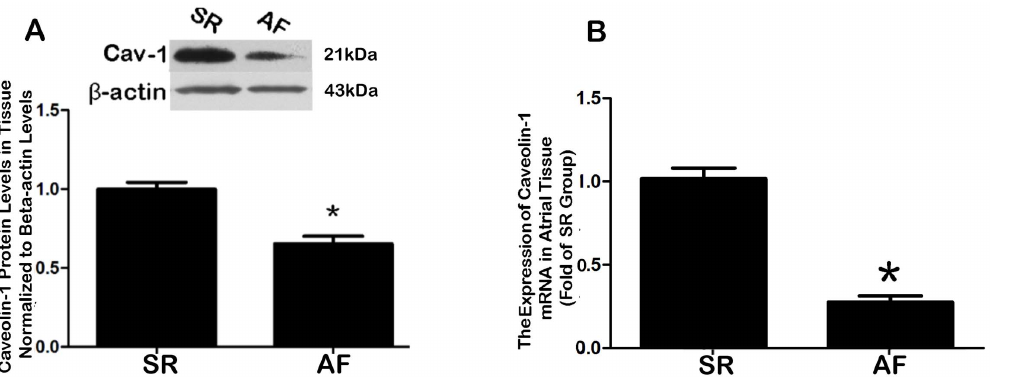
Figure 1. Quantitative analyses of caveolin-1 (Cav-1) expression in human atrial tissues. A , Comparison of atrial Cav-1 protein levels between AF and SR subjects, as determined by Western blot analysis. The left panel shows the representative bands, and the right panel the shows the mean data of band density normalized to b -actin. *P , 0.001 vs. SR, n=10; B , Comparison of atrial Cav-1 mRNA levels between AF and SR subjects, as determined by real-time RT-PCR (qRT-PCR). *P , 0.001 vs. SR; n=10. Note that the expression of Cav-1 was decreased at both protein and transcript levels in patients with AF compared to patients with SR. Cav-1, caveolin-1; SR, sinus rhythm; AF, atrial fibrillation.